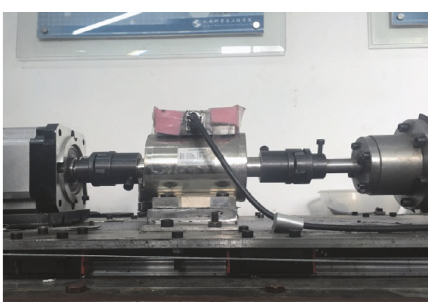
Figure 6: Precession system.